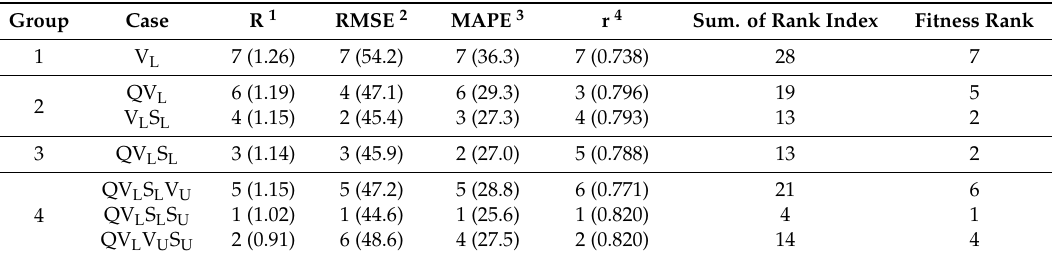
Table 3. Results of goodness-of-fit between observed and predicted